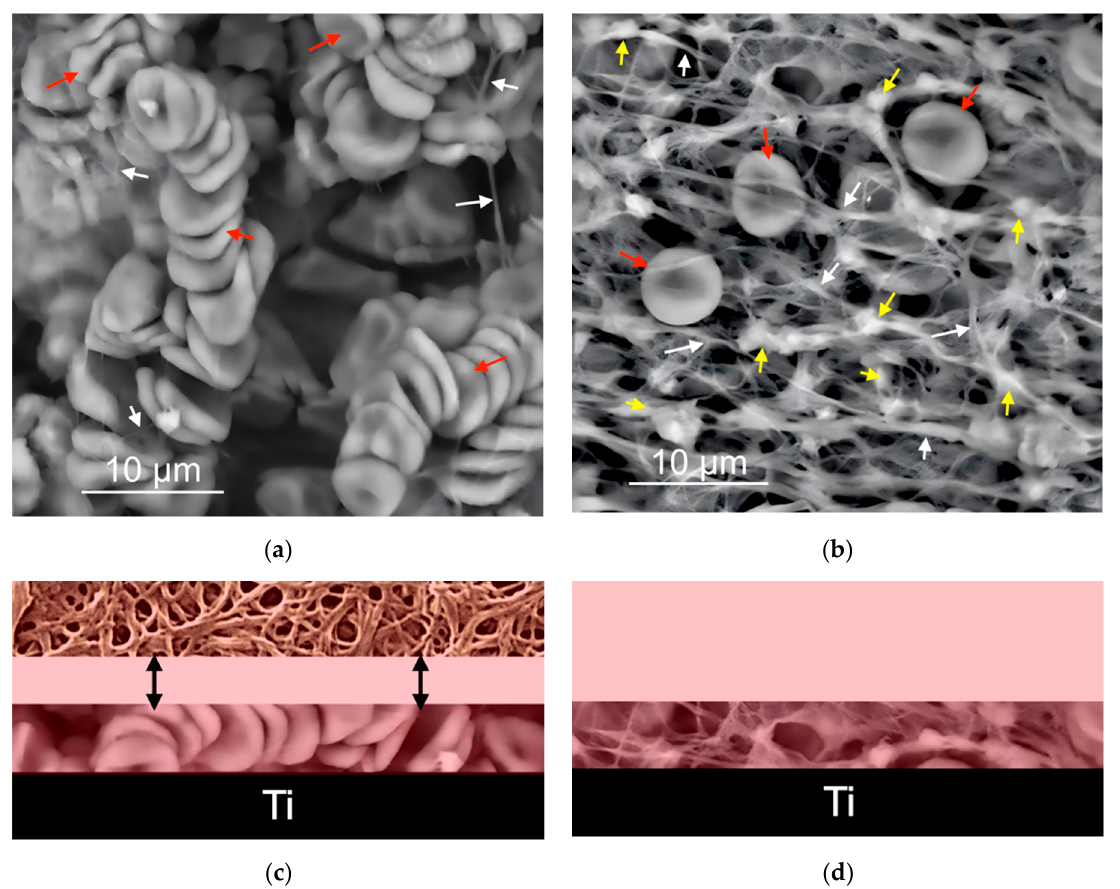
Figure 6. ( a , b ) Scanning Electron Micrographs of the implant surfaces after blood immersion exper- iments. NoCa surfaces ( a ) showed a thick layer mainly composed of red blood cells (red arrows) with scarce fibrillar material (white arrows) while Ca surfaces ( b ) showed a dense fibrin network (white arrows) with embedded platelets (yellow arrows) and some interspersed red blood cells (red arrows). Below each micrograph, a scheme illustrating the phenomena is proposed ( c , d ). The black arrows in ( c ) indicate that most of the fibrin network stays away from NoCa surfaces. Only a thick layer mostly composed of red blood cells stays attached to the NoCa surfaces. On the Ca surfaces ( d ), the clot forms at the surface and contains red blood cells and platelets entrapped within the surface-bound fibrin.